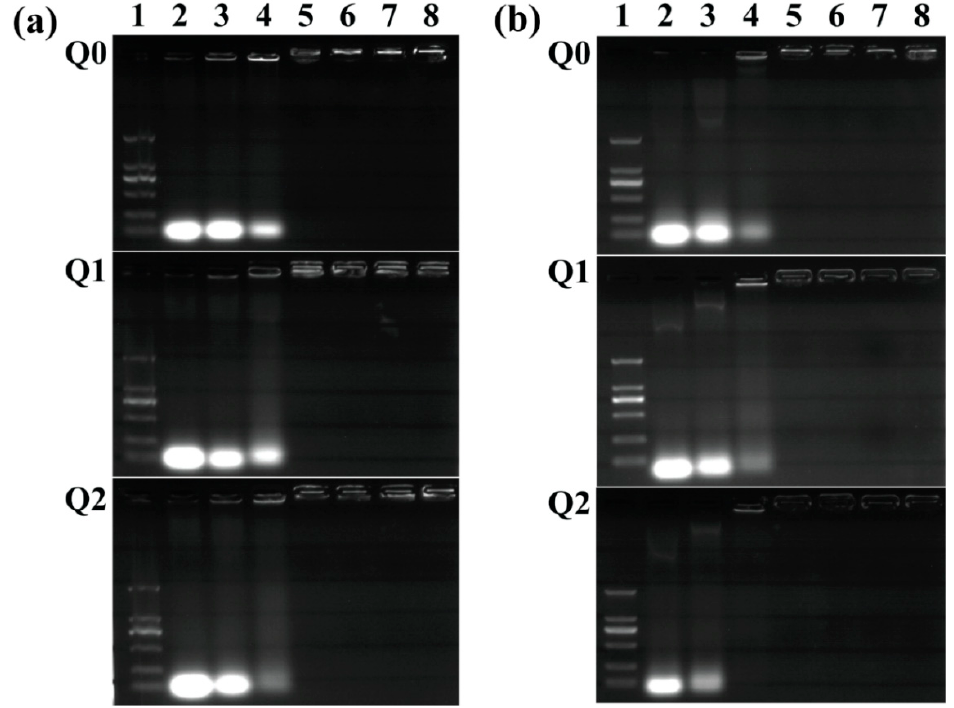
Figure 1. Gel retardation assay of B-cell lymphoma/leukemia-2 (Bcl-2) siRNA ( a ) and vascular endothelial growth factor (VEGF) siRNA ( b ) complexed with Q0, Q1 and Q2 at various N/P ratios, respectively. Lane 1: DNA marker; lane 2: N/P = 0.25:1; lane 3: N/P = 0.5:1; lane 4: N/P = 1:1; lane 5: N/P = 2:1; lane 6: N/P = 3:1; lane 7: N/P = 4:1; and lane 8: N/P = 5:1.